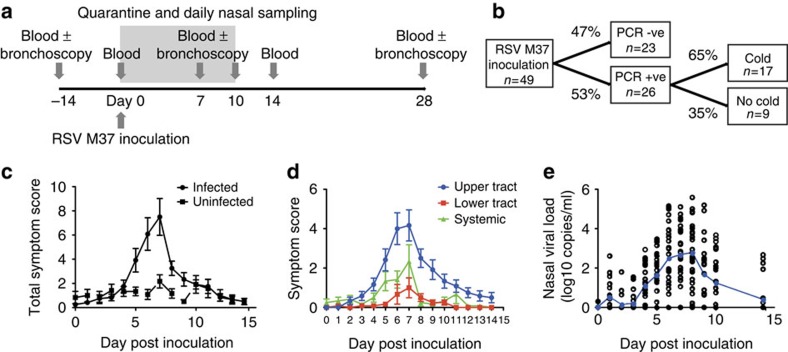
Inoculation of healthy adults with RSV causes upper respiratory tract infection.Forty-nine healthy adult volunteers were inoculated with RSV Memphis 37. (a) The study design is shown. (b) Clinical outcomes are shown. (c) Self-reported symptoms scores of 49 subjects were recorded daily. Cumulative data are shown as mean±s.e.m. Infected individuals were defined by having had RSV detected from nasal lavage on at least 2 consecutive days by qPCR of nasal lavage. (d) Symptoms from 49 subjects were categorized as originating from the upper respiratory tract (blue), lower respiratory tract (red) or as systemic (green) according to previously described criteria (see Methods). Data are shown as mean± s.e.m. (e) Viral load of 49 individuals was determined by N gene qPCR from nasal lavage. Individual data points and means are shown.